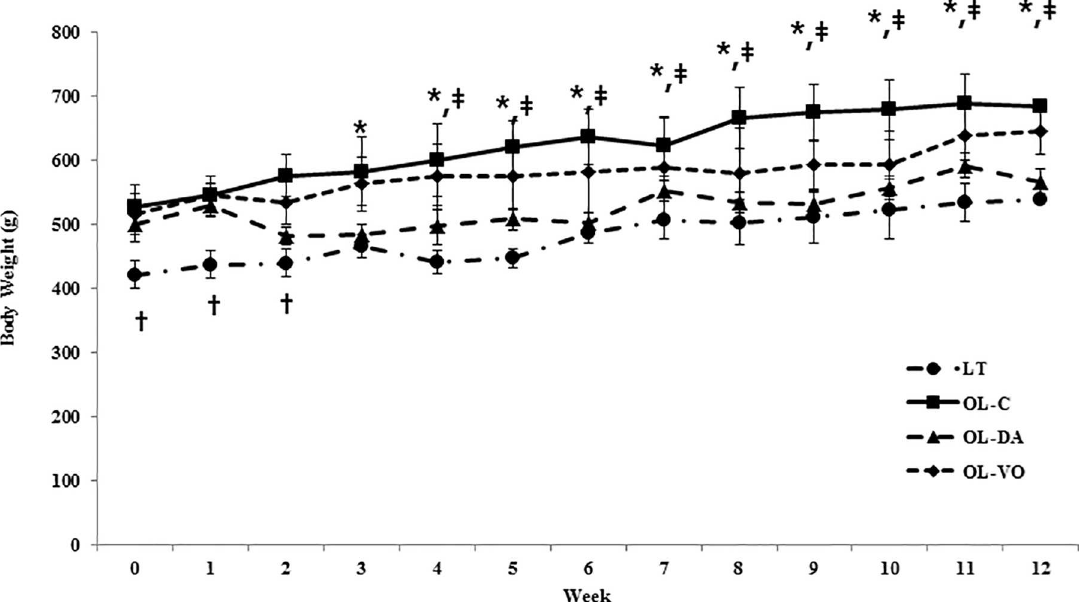
Fig 1. Changes in body weight during the experimental period in LETO (LT) and OLETF rats with saline (OL-C), dapagliflozine (OL-DA) or voglibose (OL-VO) treatment. * P < 0.05, OL-C vs . other groups; † P < 0.05, LT vs . other groups; ‡ P < 0.05, OL-DA vs . OL-VO. Values are expressed as means ±